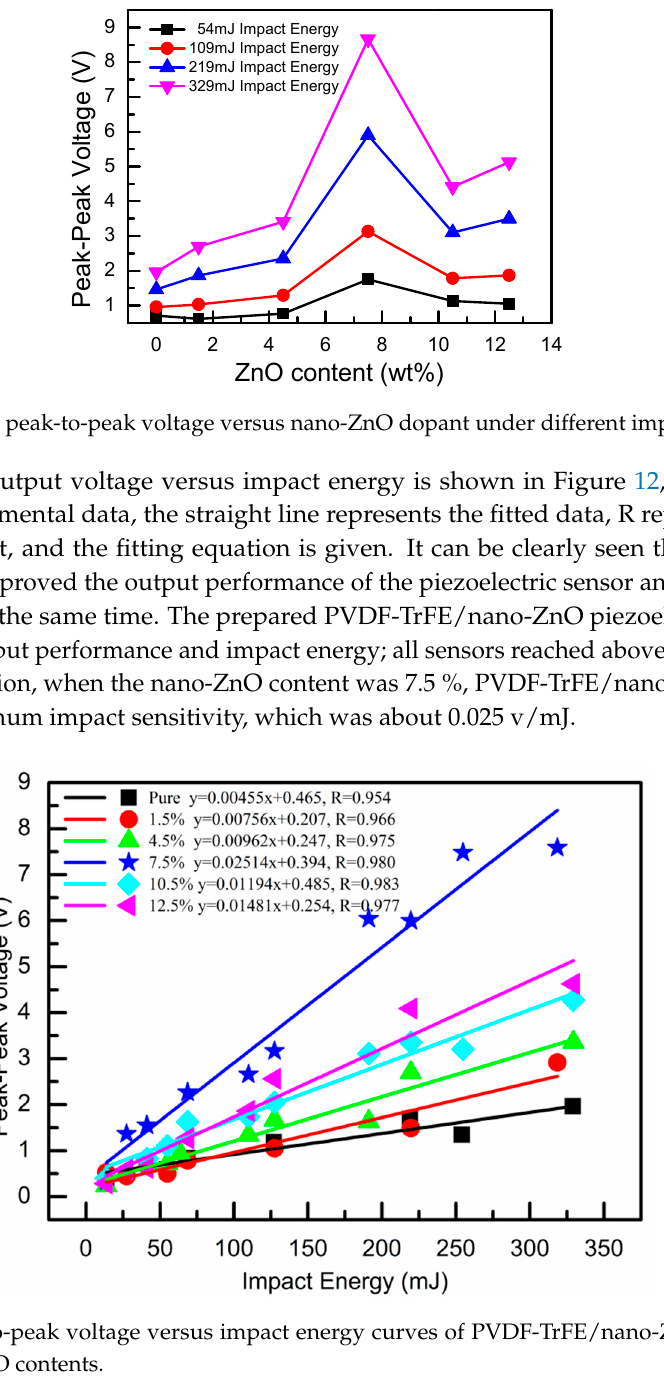
Figure 10. The output signals of PVDF-TrFE/nano-ZnO films with different nano-ZnO contents under different impact energy: ( a ) 54 mJ impact energy; ( b ) 109 mJ impact energy; ( c ) 219 mJ impact energy; and ( d ) 329 mJ impact energy.